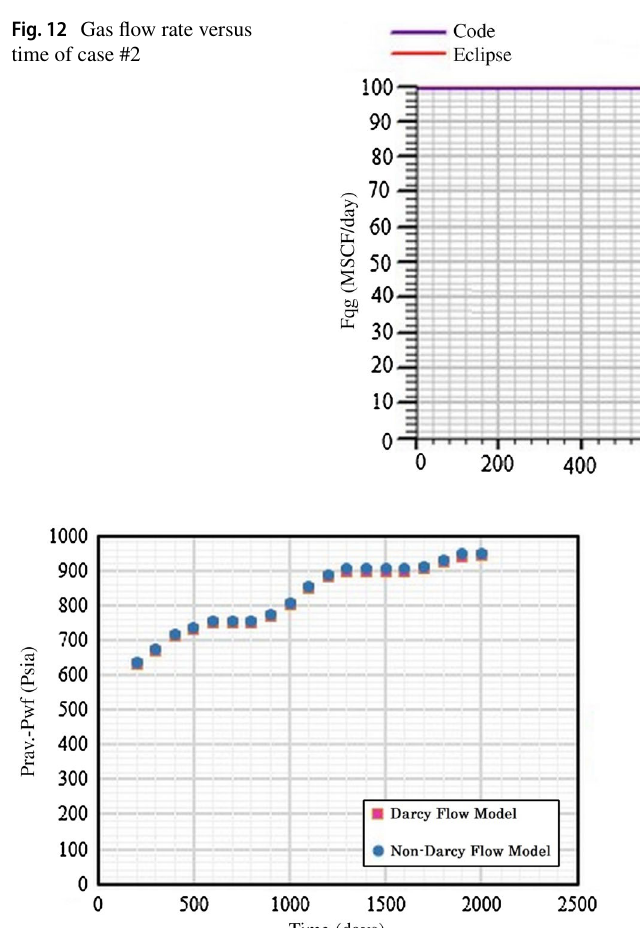
Fig. 12 Gas flow rate versus time of case #2